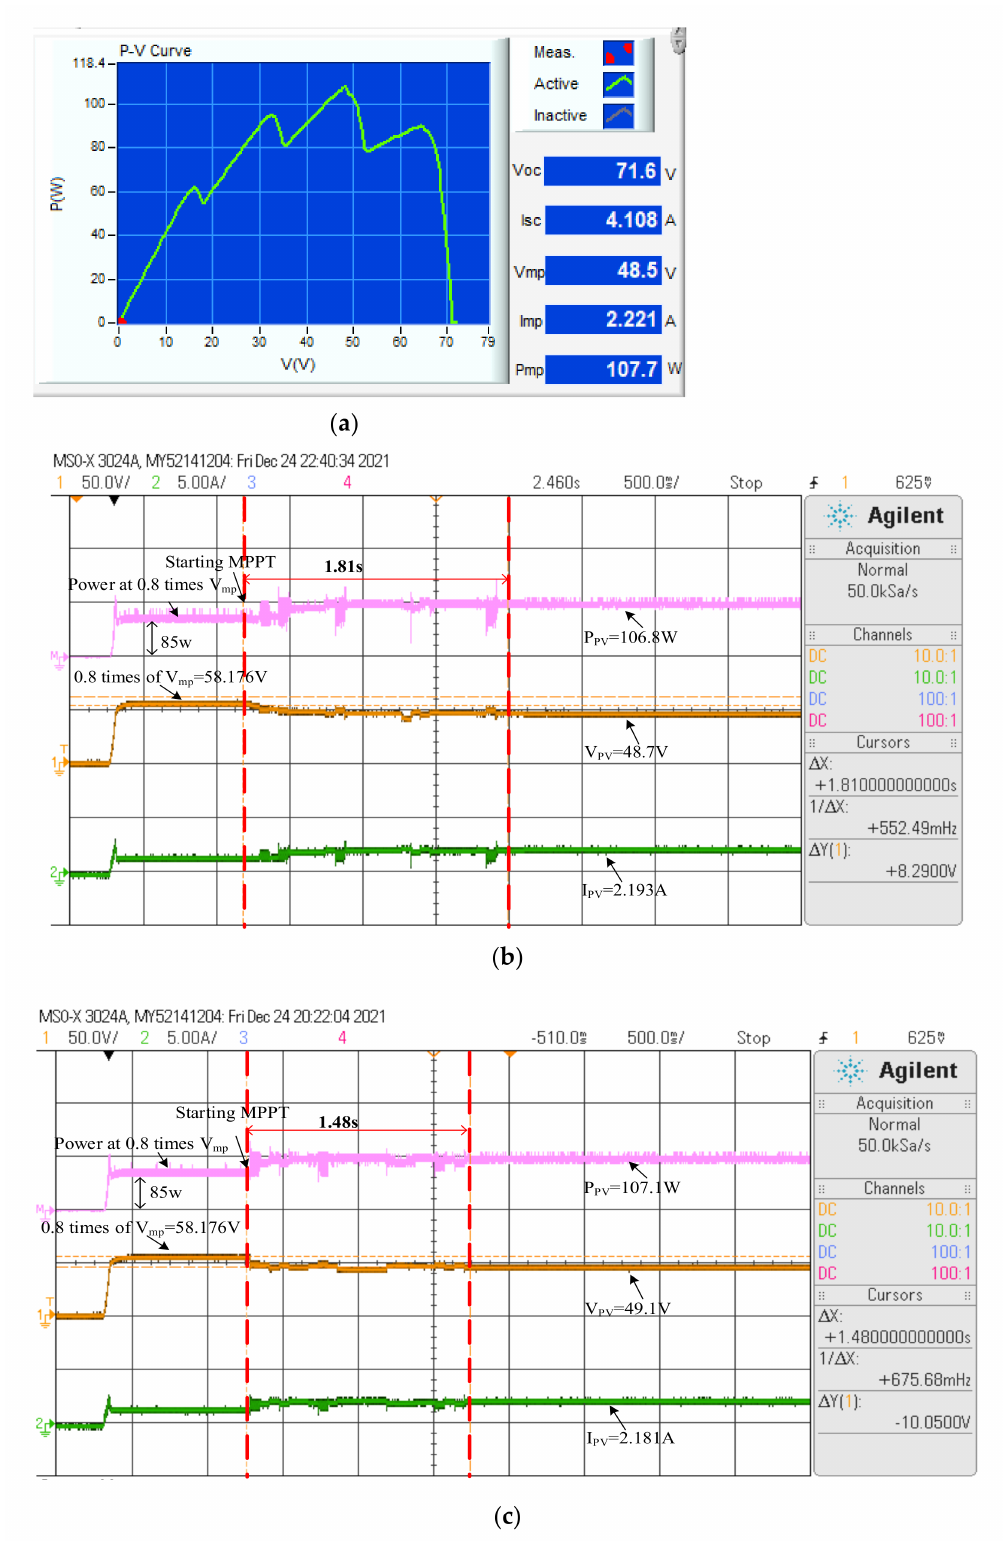
Figure 19. Test results of the MPPT of photovoltaic module array in Case 4: ( a ) P-V characteristic curve; ( b ) tracking curve of the traditional ABC algorithm ( P mp = 106.8 W); ( c ) tracking curve of the I-ABC algorithm ( P mp = 107.1